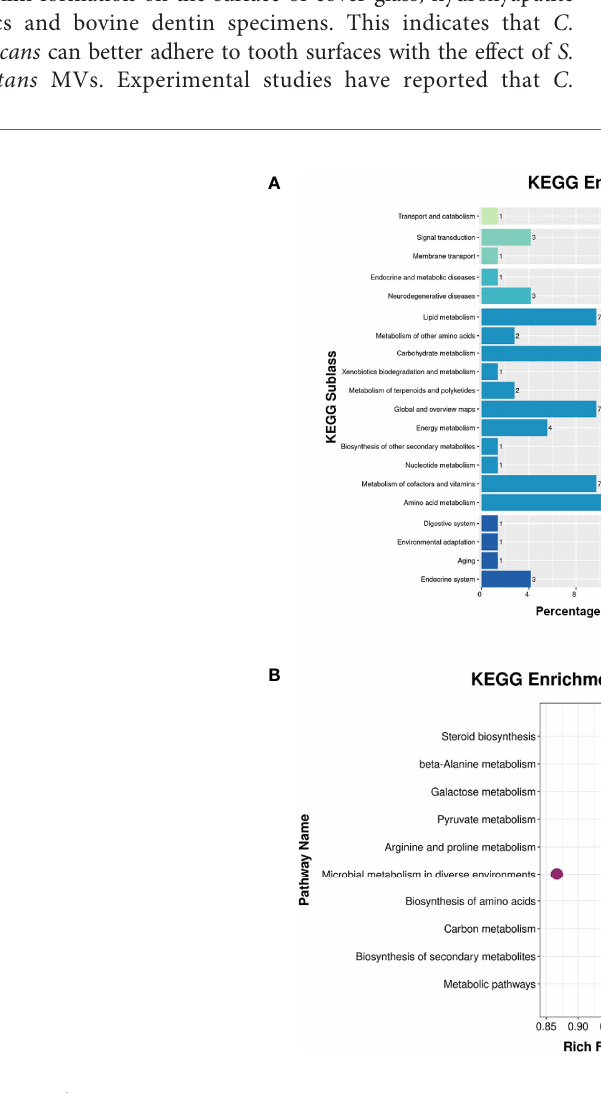
FIGURE 5 | Integrated analysis of the proteome and the metabolome. (A) KEGG enrichment analysis. (B) Top-10 KEGG pathways involved in both proteomic and metabolic